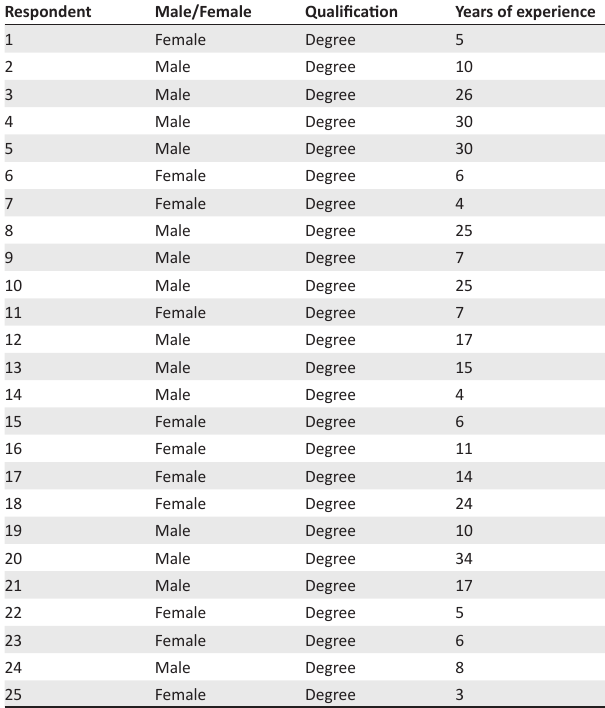
TABLE 1: Demographic information of